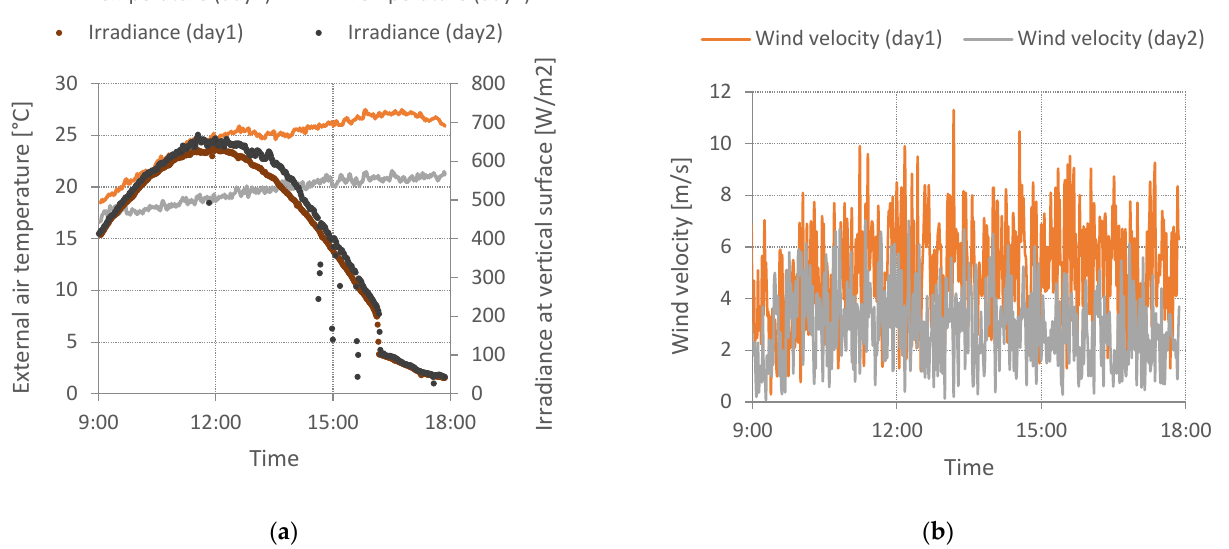
Figure 3. Measured weather data: ( a ) external air temperature and irradiance at vertical surface, ( b ) wind velocity.